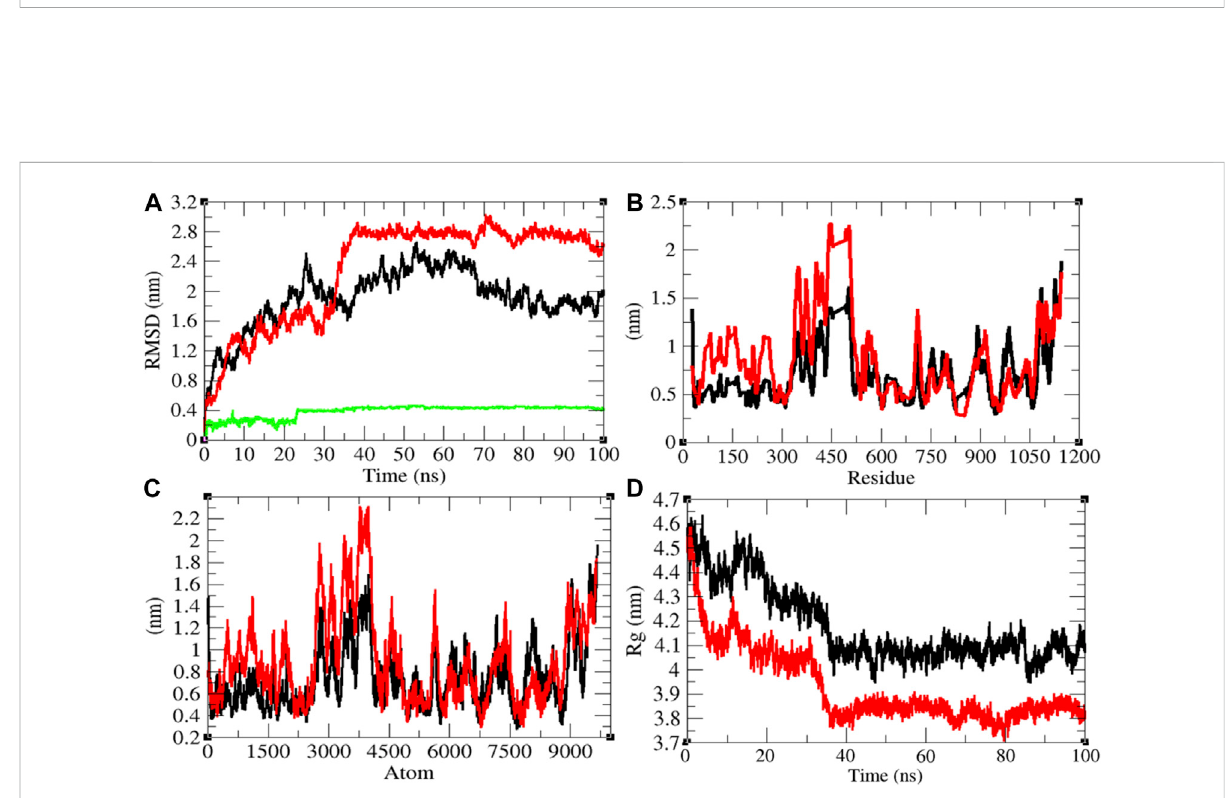
Structural dynamics ofSprotein. (A) Rootmeansquaredeviationsplotfor Sprotein(black), Sprotein-remdesivir(red),andremdesivir(green)asa function of time. (B) Root mean square fl uctuations vs. residues. (C) Root mean square fl uctuations vs. atoms. (D) Radius of gyration ( R g )